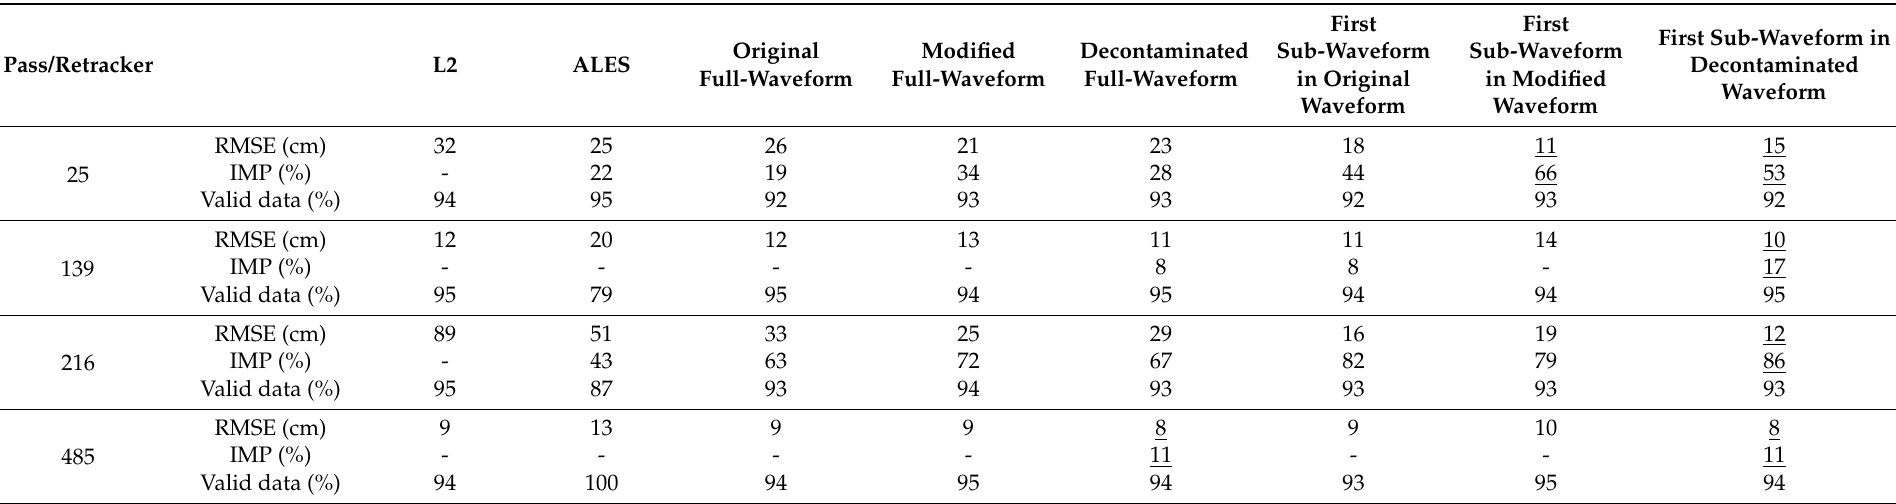
Table 8. Performance evaluation of our retacking scenarios against ALES dataset and L2 product in front of tide gauge in terms of RMSE (cm) and IMP (%). It also includes the percentage of accepted measurements in all cycles (valid